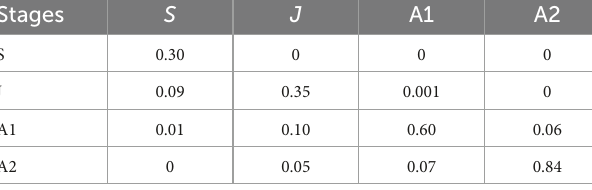
TABLE 1 Priors for the transition matrix for estimating the posterior transition